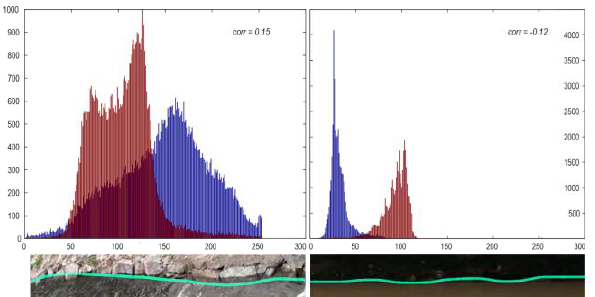
Figure 5. Histogram analyses of spatio-temporal textures in relation to respective ROIs. Left: Study area (II), dissimilarities enable spatio-temporal texture, correlation factor corr = 0.08 . Right: less spatio-temporal variability ( corr = 0.97 ).